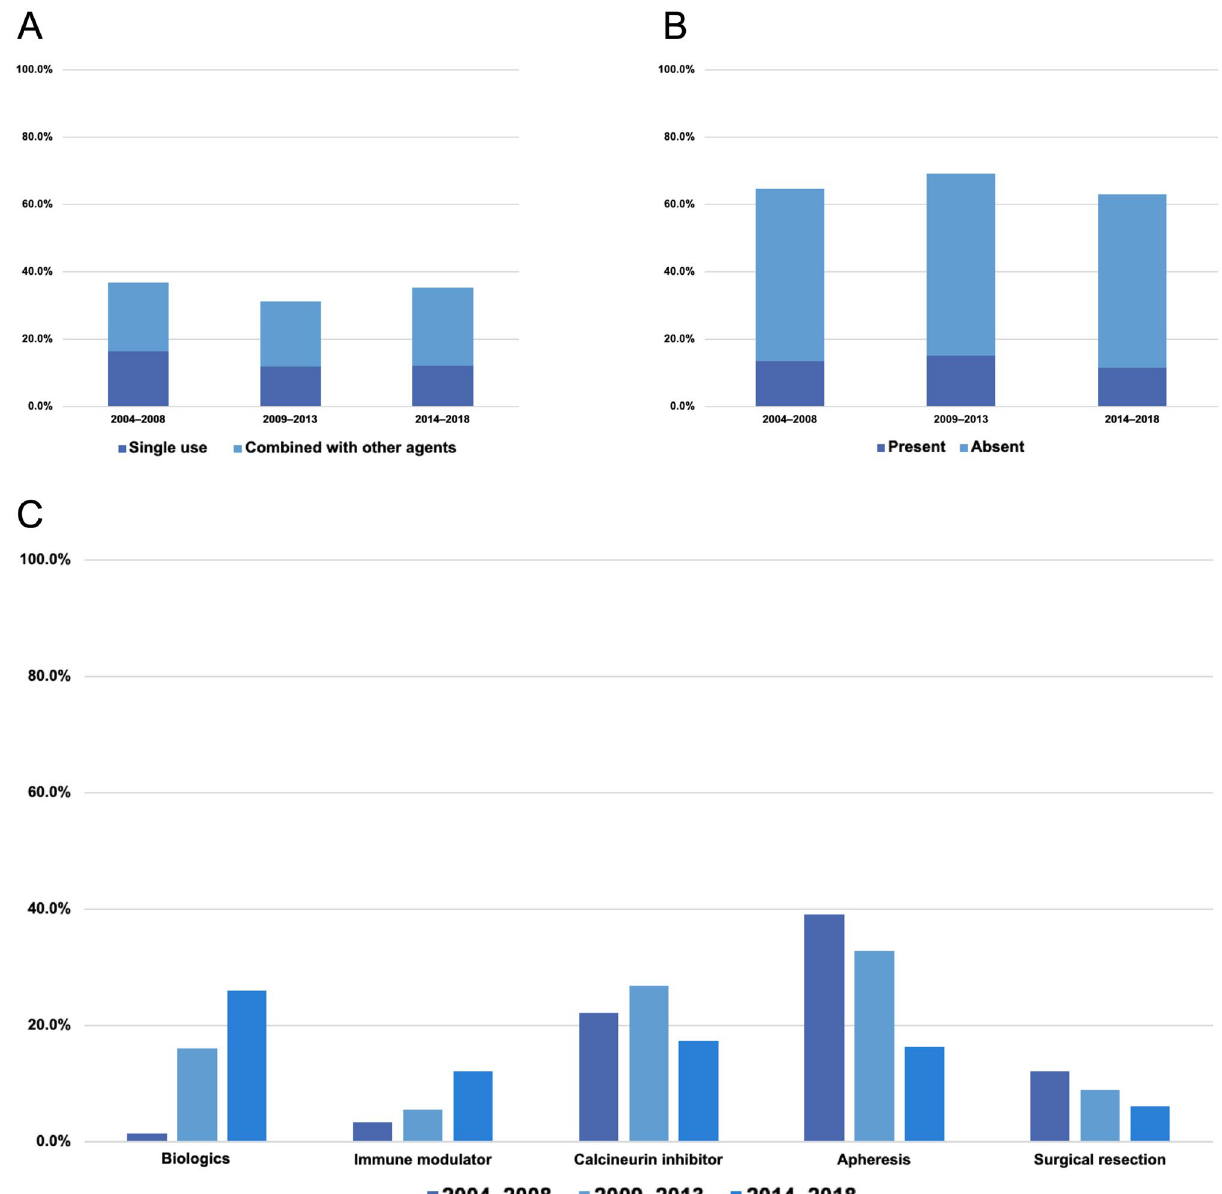
Figure 2. Transitions of treatments in patients with moderate to severe ulcerative colitis exacerbations. ( A ) 5-Aminosalicylates, ( B ) Corticosteroids (“present” means previous history of COR-REF or DEP), ( C ) Other